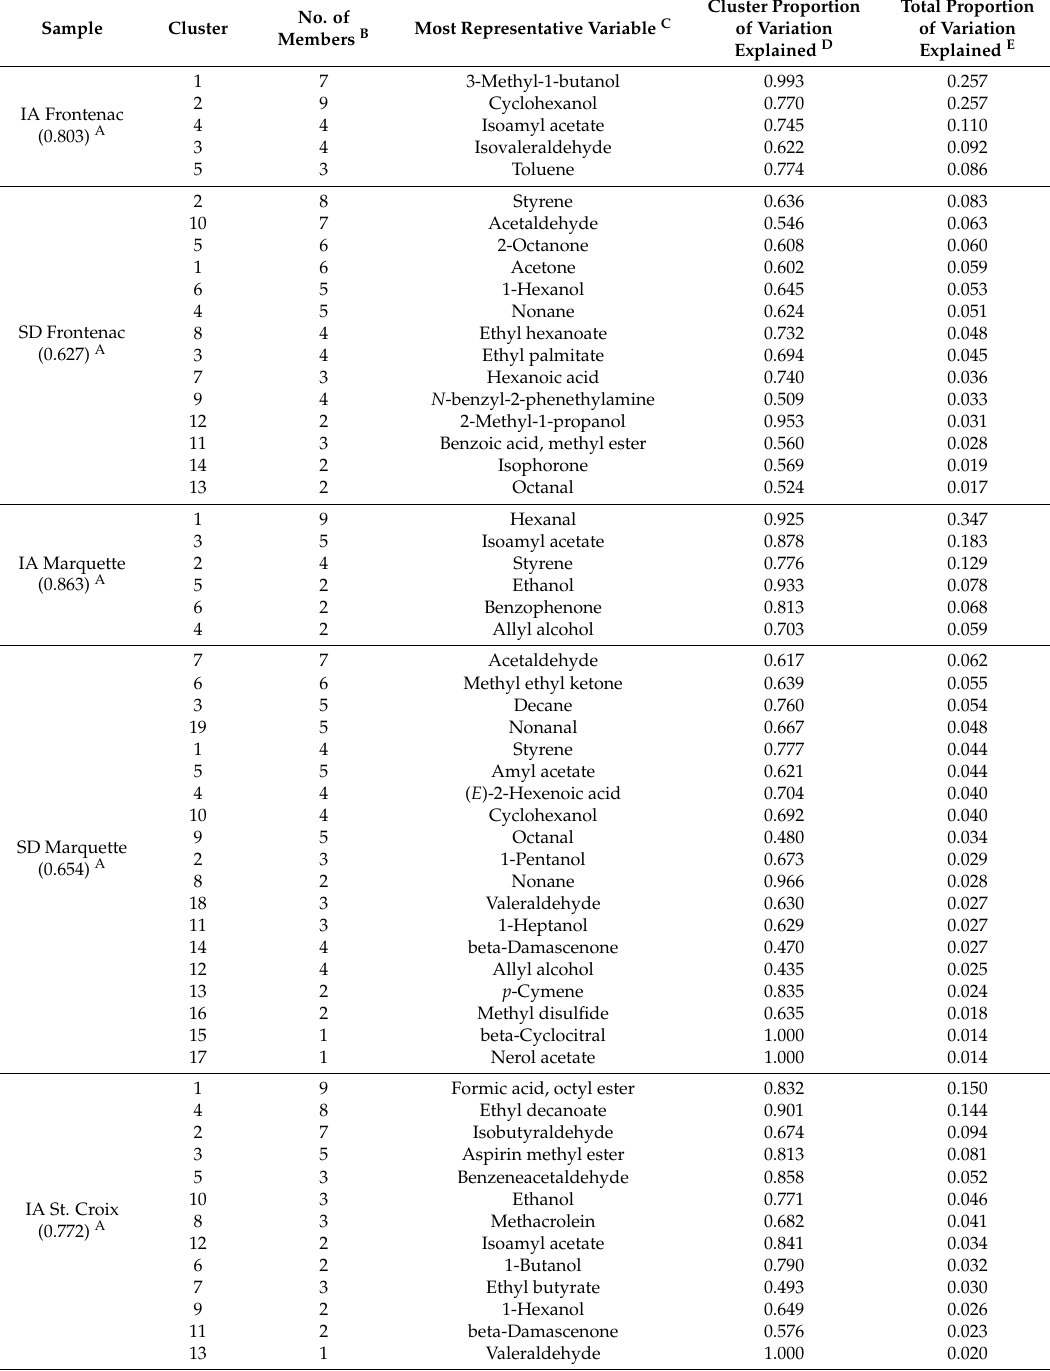
Table 3. ‘Characteristic’ VOCs emitted from crushed berries of Frontenac, Marquette, St. Croix, and La Crescent grapes grown in Iowa and South Dakota. These VOCs were indicated to be the most representative variable from hierarchical clustering analysis after the PCA (JMP Pro 12.0.1, SAS Institute Inc., Cary, NC,